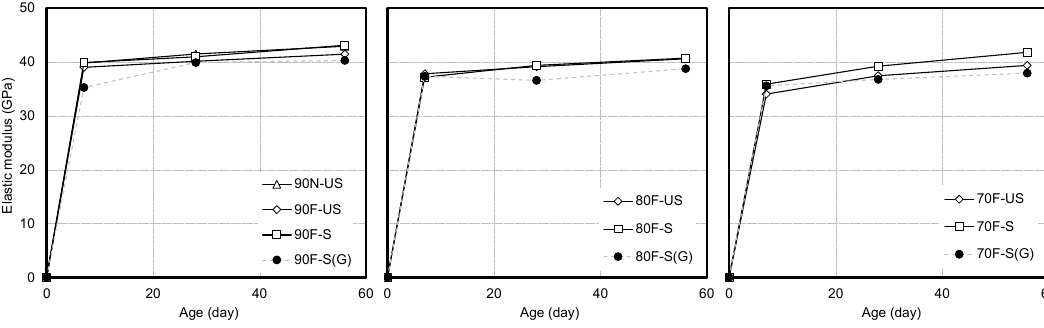
Figure 6. Elastic modulus of high-strength concrete based on limestone and granite.